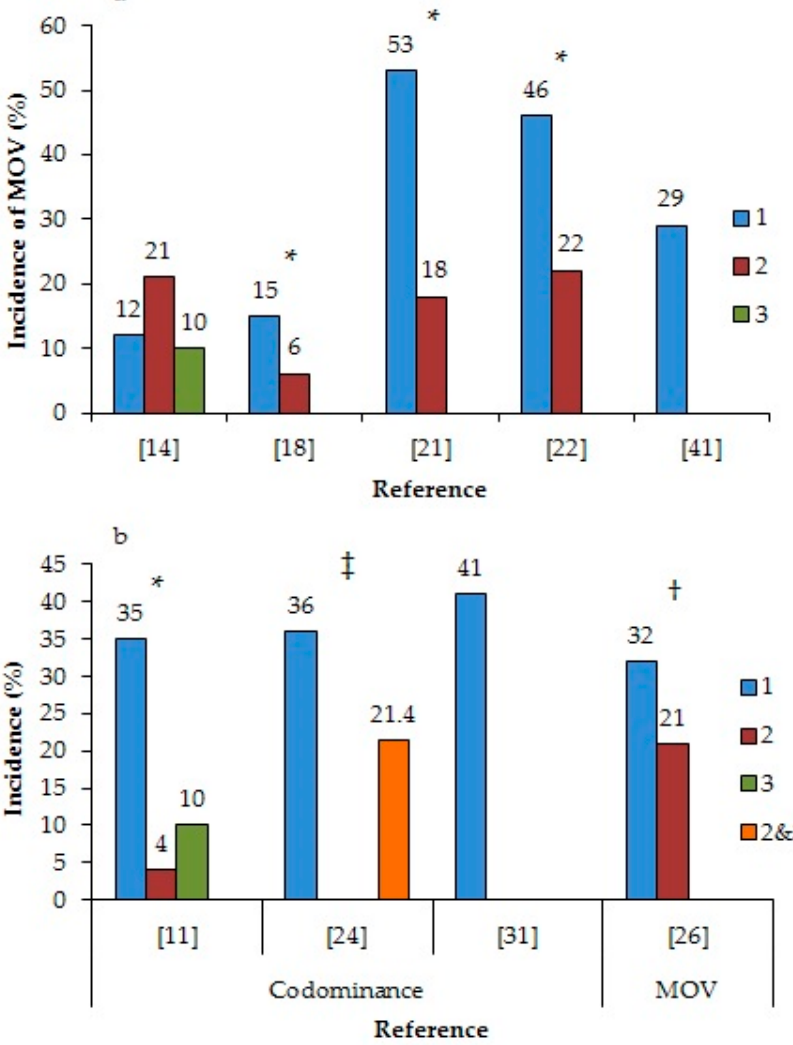
Figure 1. ( a ) The incidence of multiple ovulations (MOV) depending on the ovulation number following anestrus and ( b ) the incidence of codominance or MOV depending on the follicular wave number within an estrous cycle. * difference within a reference ( p < 0.05); † tendency for a difference within a reference (0.05 < p < 0.10); ‡ no statistical comparison.